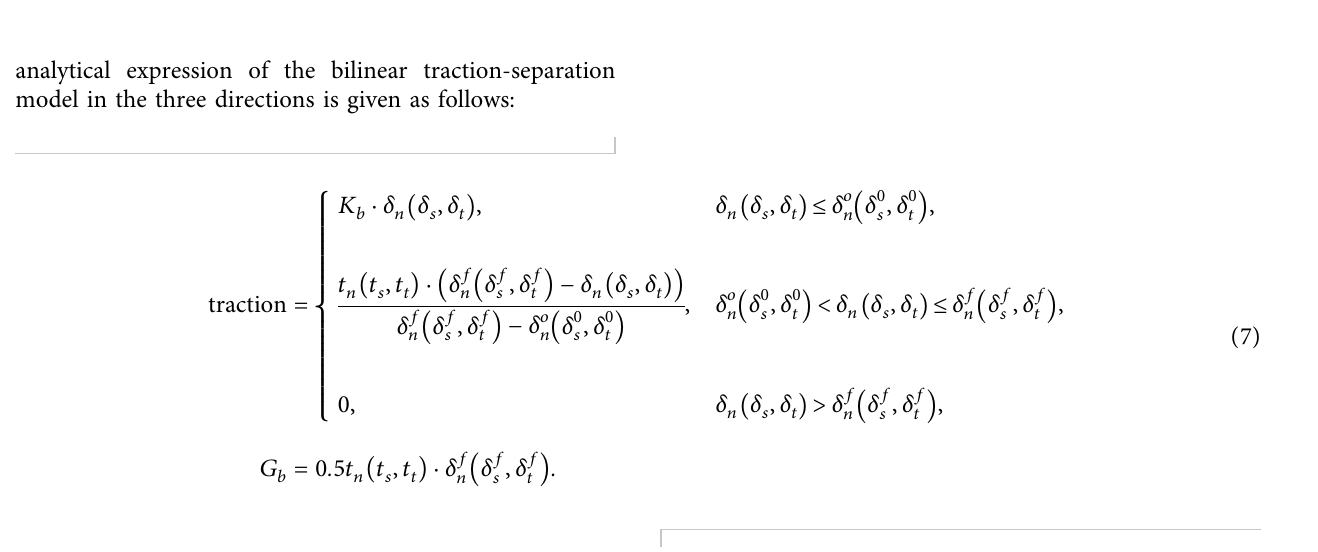
Figure 9: Typical traction-separation